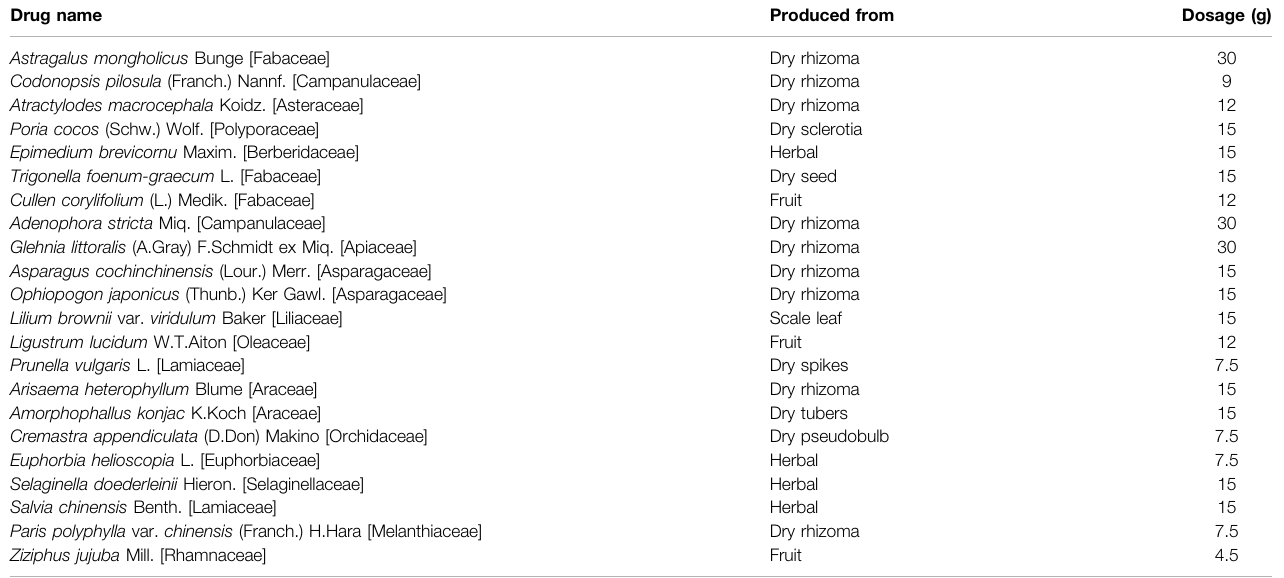
TABLE 1 | Composition of Yiqi-Yangyin-Jiedu decoction. Drug name Produced from Astragalus mongholicus Bunge